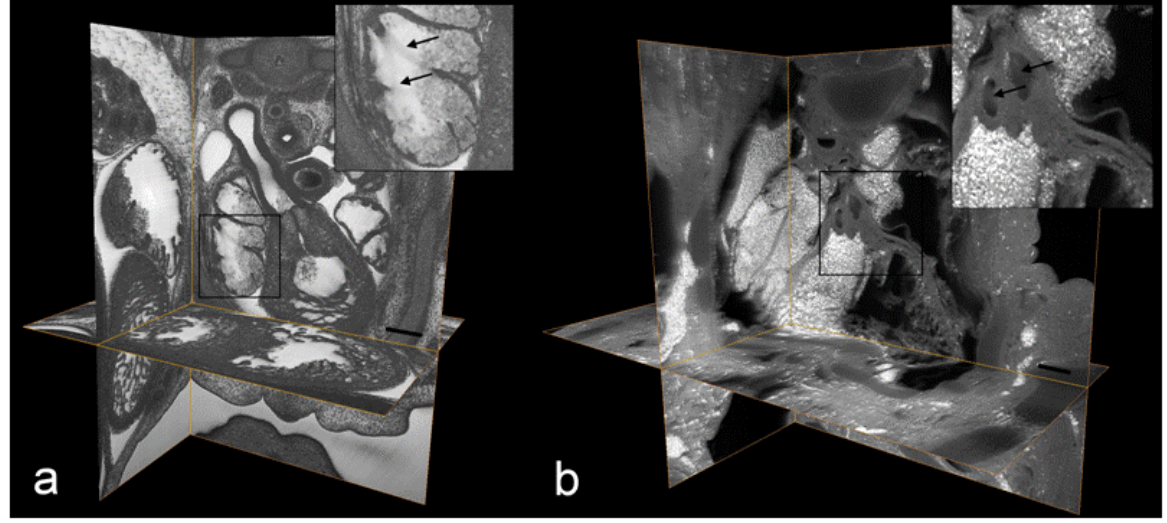
FIGURE 1. Shining through artefacts in HREM volume data (a) and EFIC volume data (b) of thoraces of 14.5 dpc mouse embryos. Both data were generated from quickly produced blocks and show regionally enhanced shining through artefacts especially in the cardiac chambers and the great intrathoracal arteries (arrows in inlays). Careful block preparation reduces the extension of the artefacts (Fig. 2). Scale bars, 200